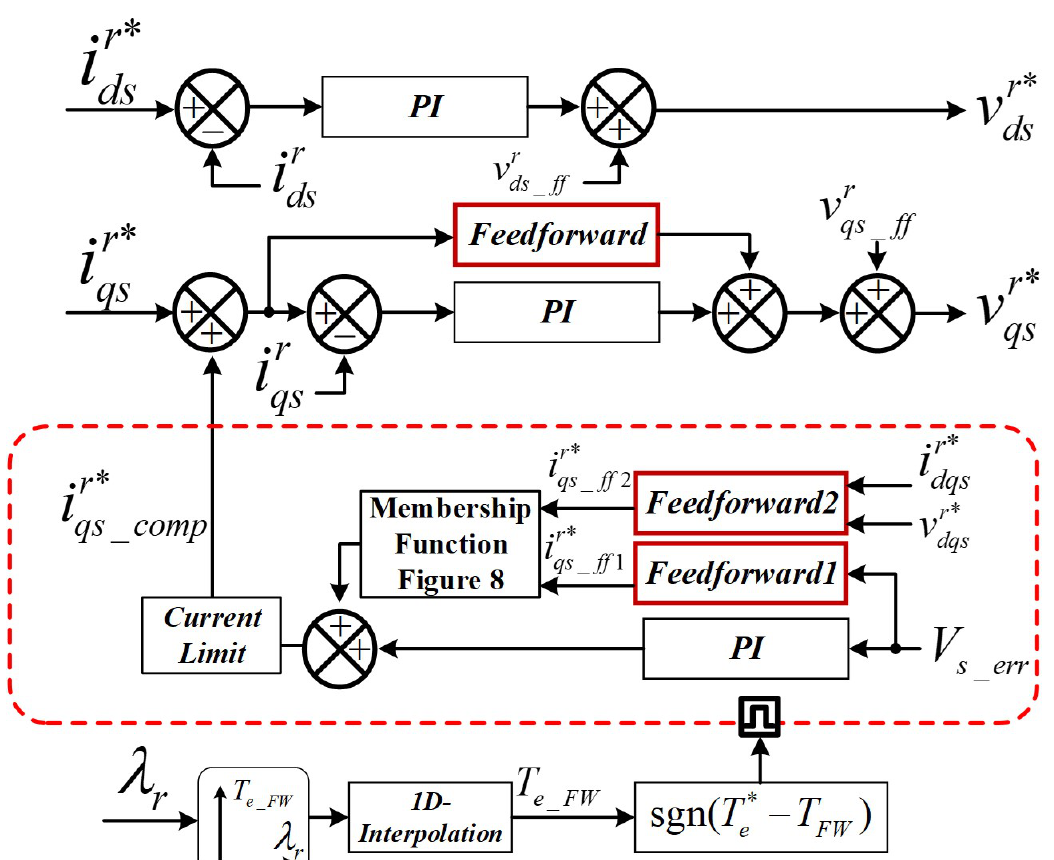
Figure 5. Proposed interpolation error compensation